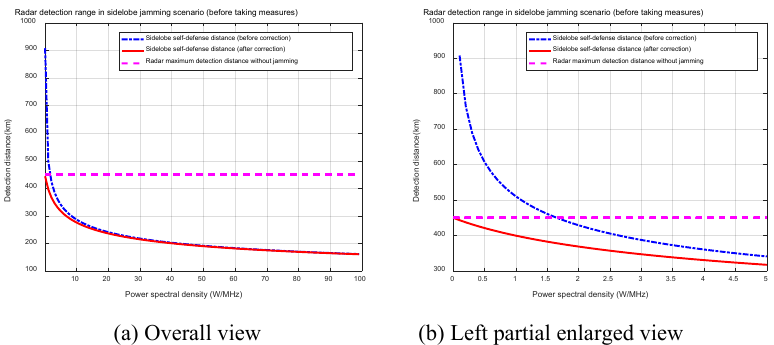
Fig. 1. Comparison of radar sidelobe self-defense distance curves. The blue dotted line in the figure is the radar sidelobe self-defense distance curve before correction, the red solid line is the radar sidelobe self-defense distance curve after correction, and the purple dotted line is the maximum radar detection distance without